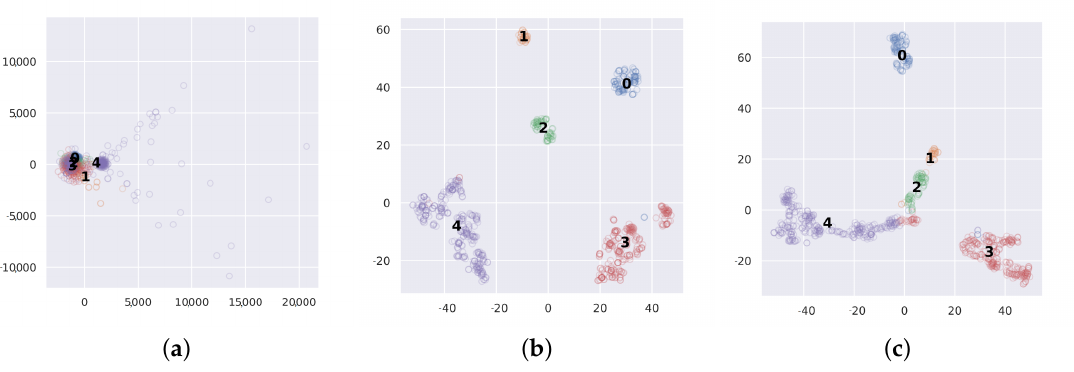
Figure 10. Visualization using t-SNE with whole data case: ( a ) Input, ( b ) One-shot learning, and ( c )